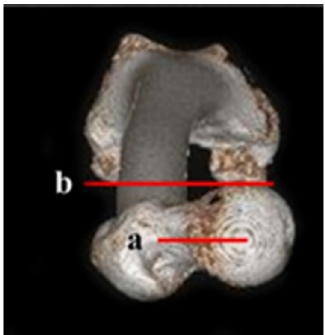
Figure 9. Specimen nos. 6 and 18. (a) Specimen no. 6, the H-N line showed the negative value of anteversion despite the H-G line showing a positive value for all three observers. (b) Specimen no. 18, the H-N line showed the negative value of anteversion despite the H-G line showing a positive value in all three observers.